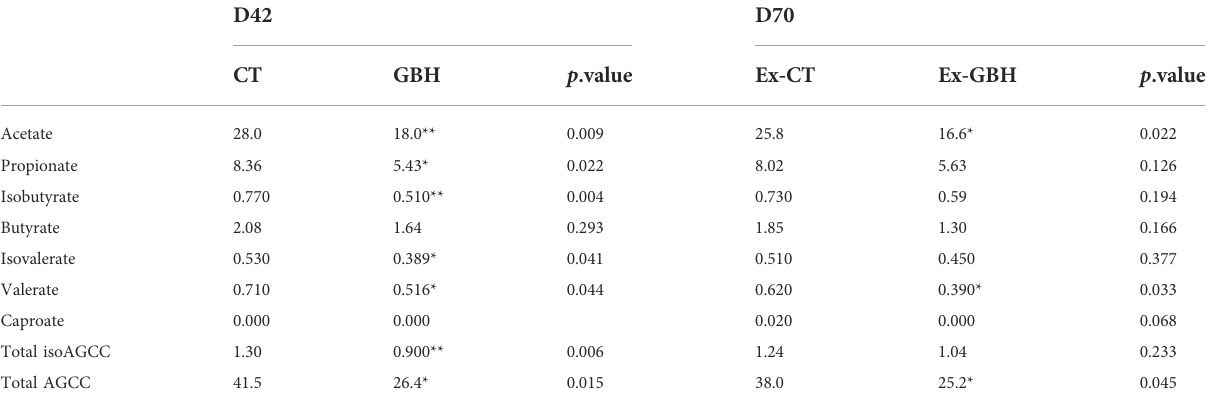
TABLE6Short-chainfattyacidconcentrationincecalcontent(µmol/g)duringdietaryGBH(GBH,D42,n=8)exposureincontrol(CT,n=8)andafter dietary GBH exposure (Ex-CT, D70, n = 12 and Ex-GBH, n = 11